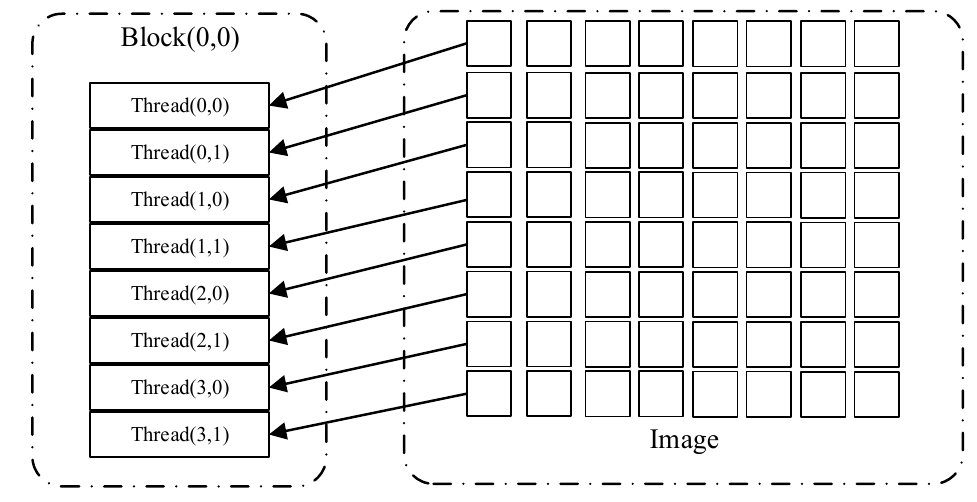
Figure 6. The relationship between image pixels and threads.